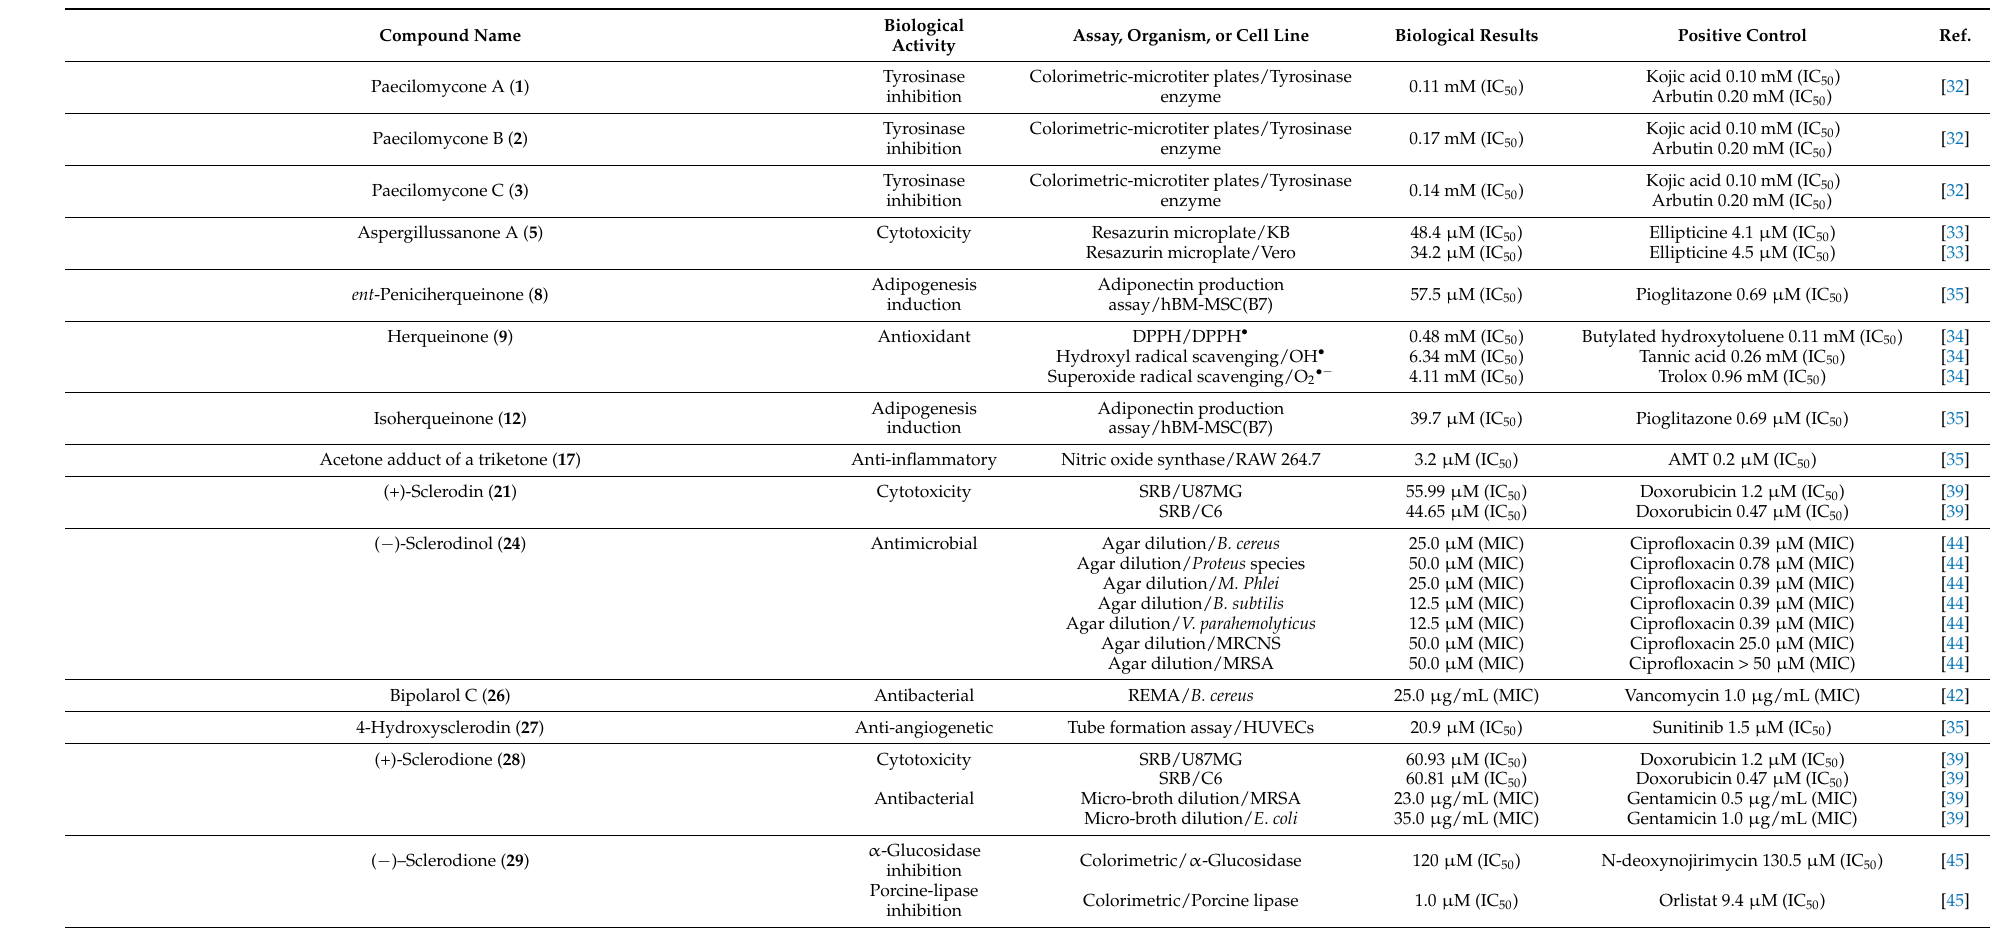
Table 2. Biological activities of the most active fungal